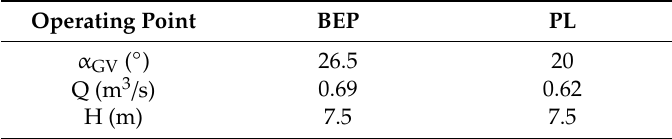
Table 1. Operating condition parameters of the Porjus U9 model. Experimental values.